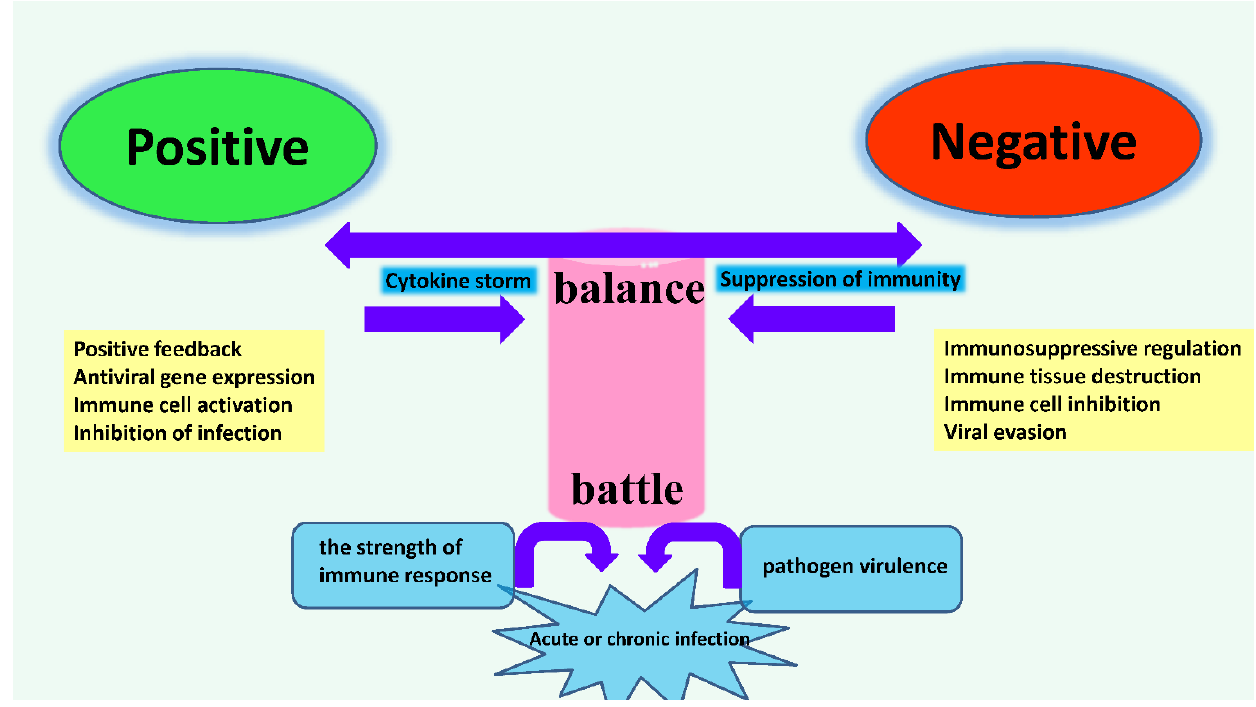
Figure 8. The sketch map of dynamic balance of immune regulation in birds. Interferon maintains a balance in antiviral actions against immunosuppressive effects during viral infection. The precise control of interferon balance is critical for efficient viral clearance without harmful immunopathology. Both sides of interferon regulation (positive and negative) can be affected mutually by the strength of immune response and pathogen, like an immune battle. In immune regulation of host, both the cytokine storm and suppression of immunity should be